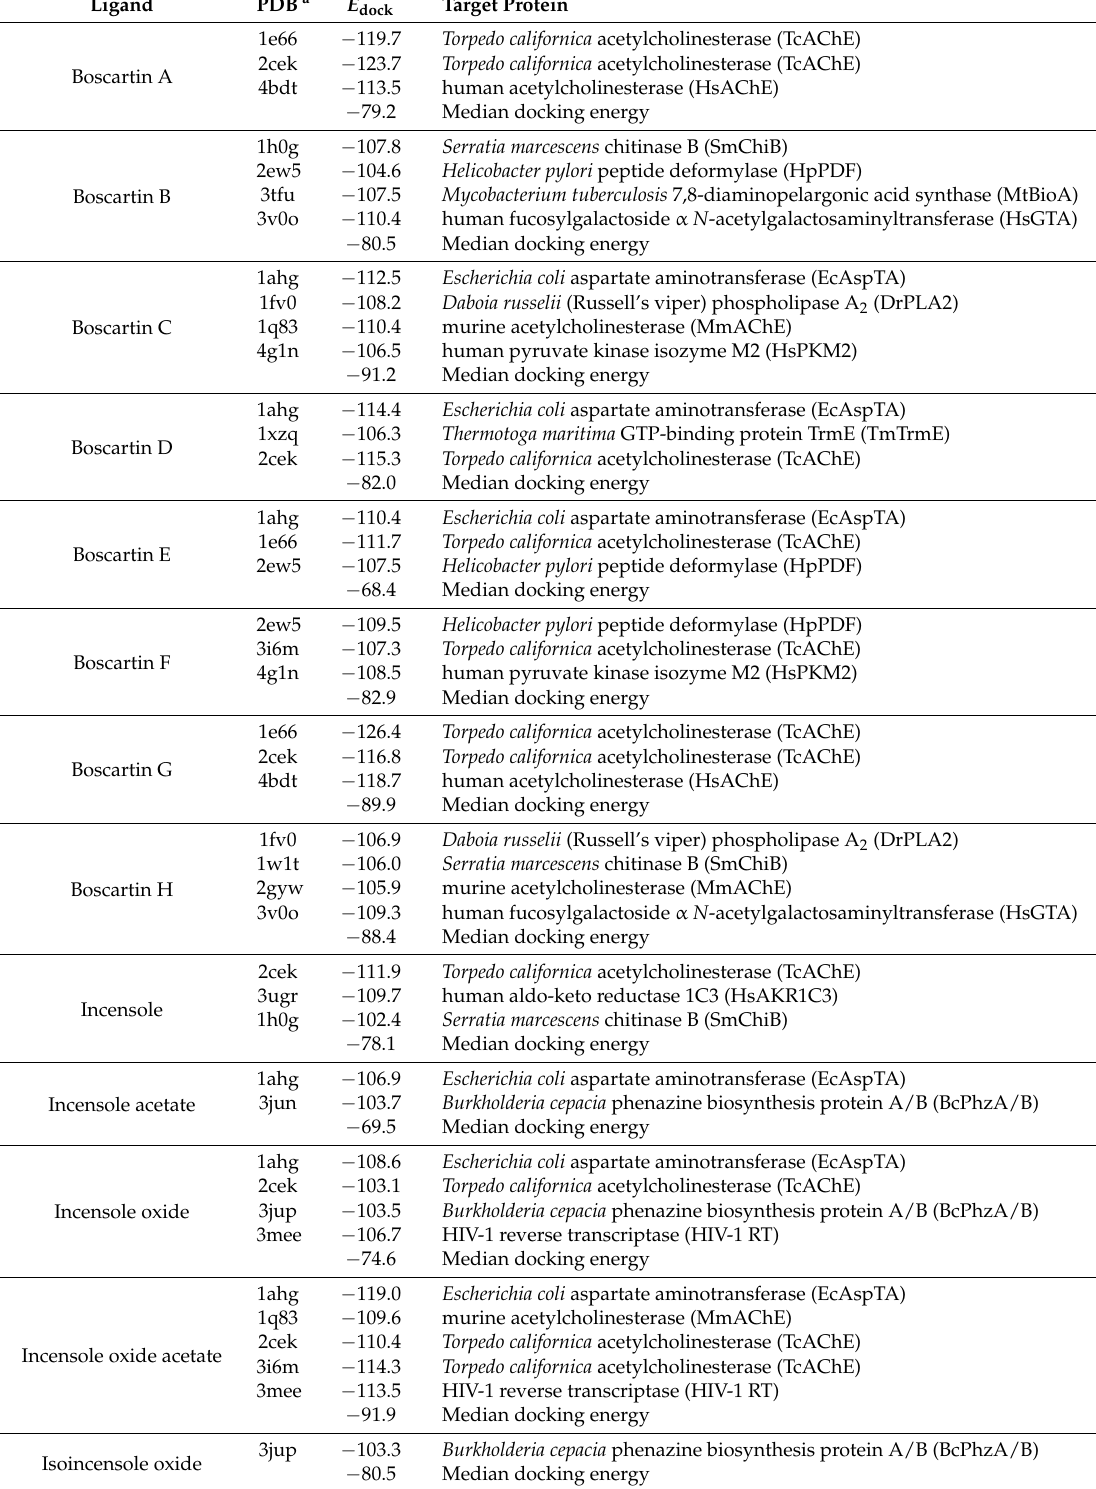
Table 1. Protein targets with the most exothermic docking energies ( E dock , kJ/mol) for Boswellia cembranoid